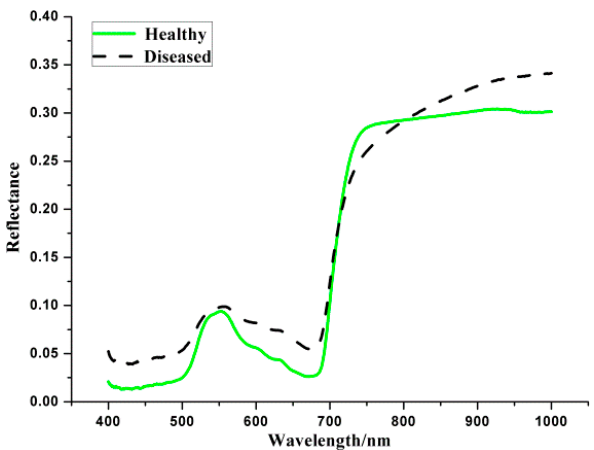
Figure 3. Average spectral reflectance curves of healthy and infected samples.